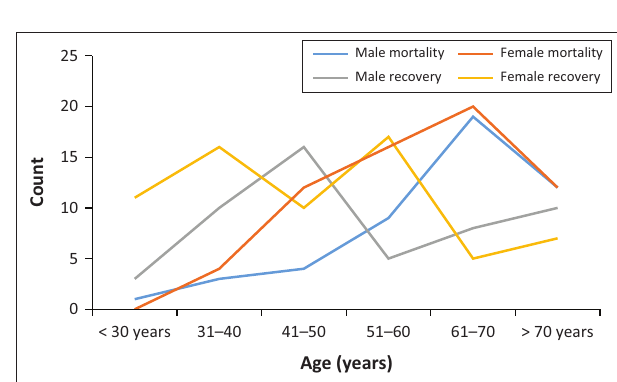
Female mortality Female